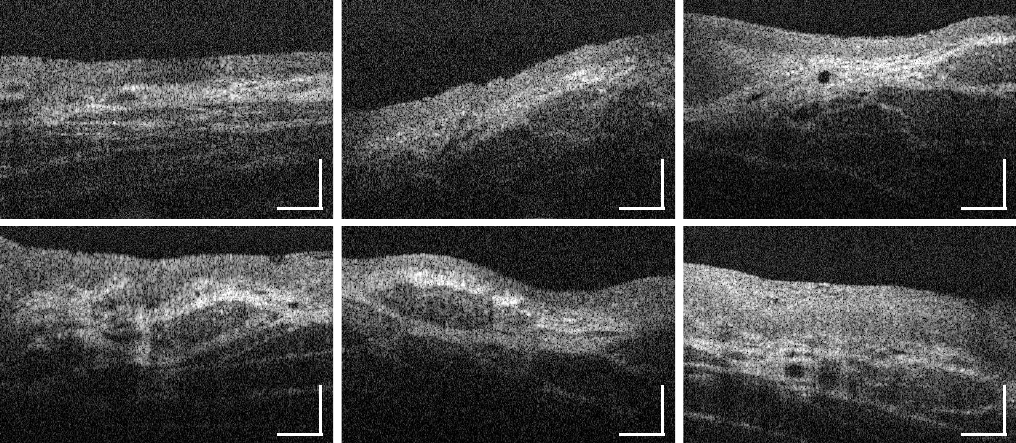
Figure A25. Supplementary intensity-based OCT cross sections of the mucosal tissue of the oropharynx (MP15, Figure 1). Scale bars: 200 µ